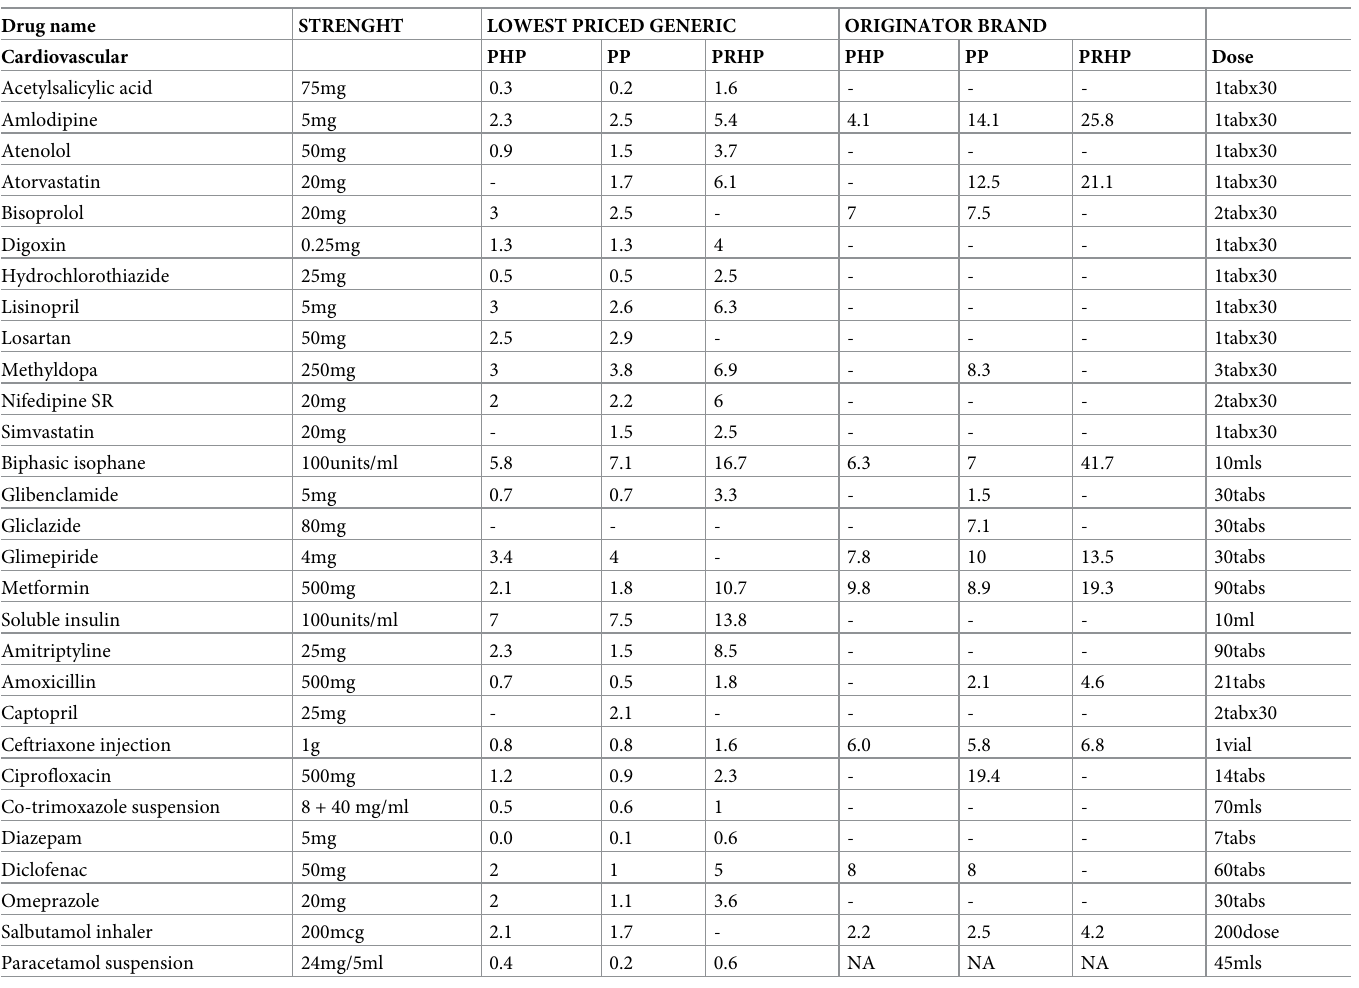
Table 5. Affordability of cardiovascular, anti-diabetic and global